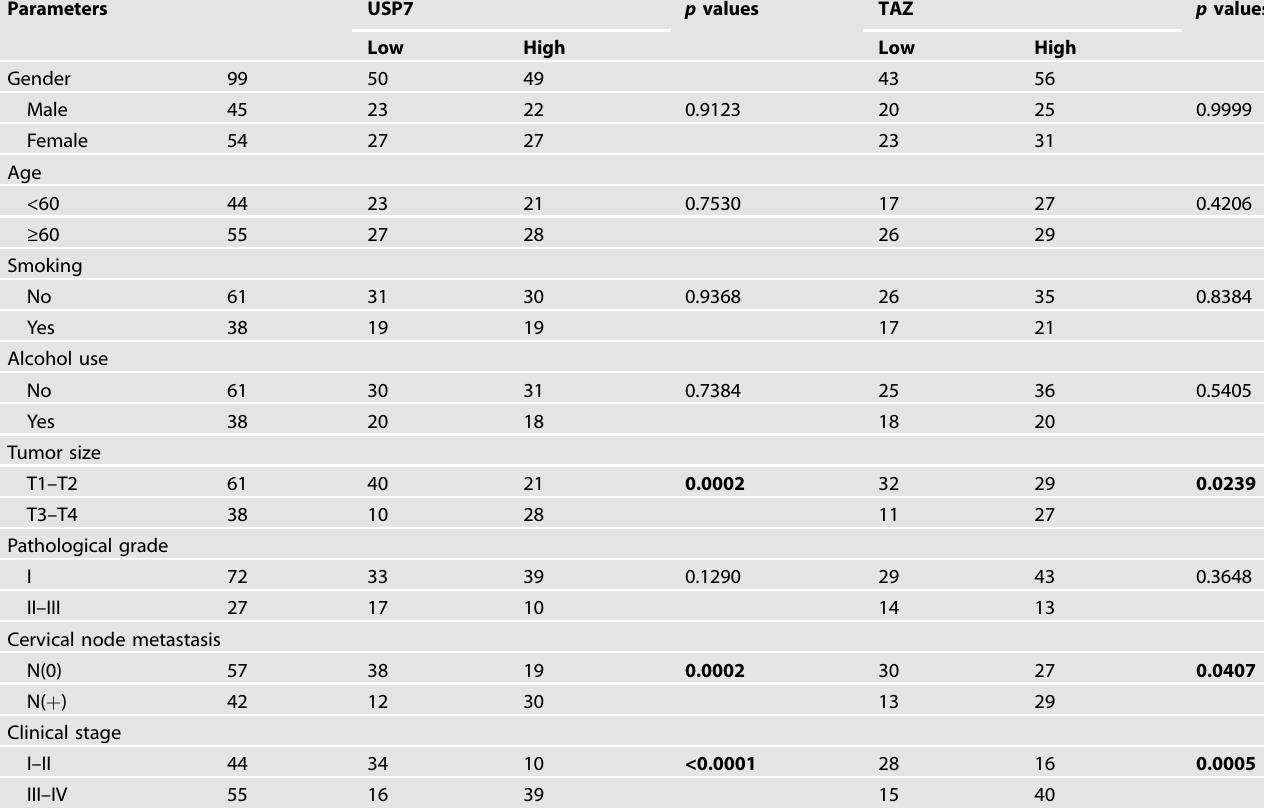
Table 1. High USP7/TAZ expression and their associations with clinicopathological parameters in 99 patients with HNSCC.